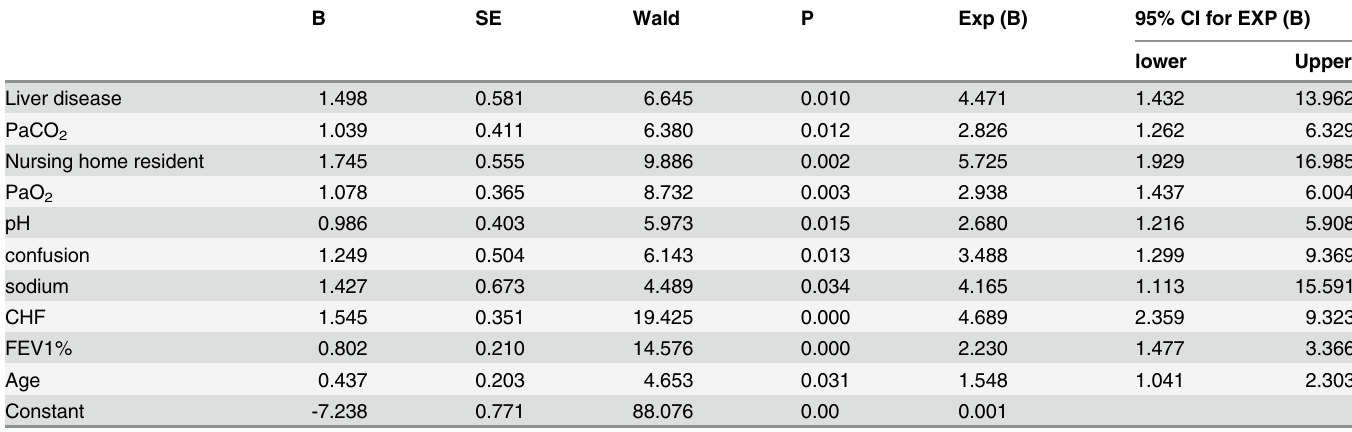
Table 3. Logistic regression analyses of the risk factors associated with mortality in AECOPD